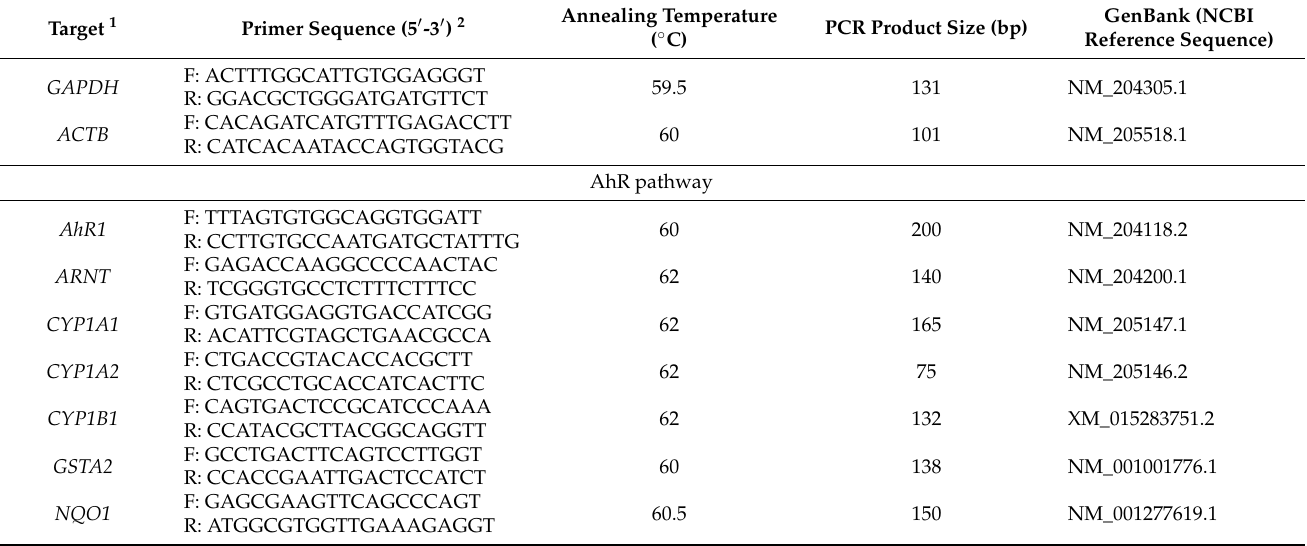
Table 1. Oligonucleotide primers used for gene expression of selected targets by quantitative real-time